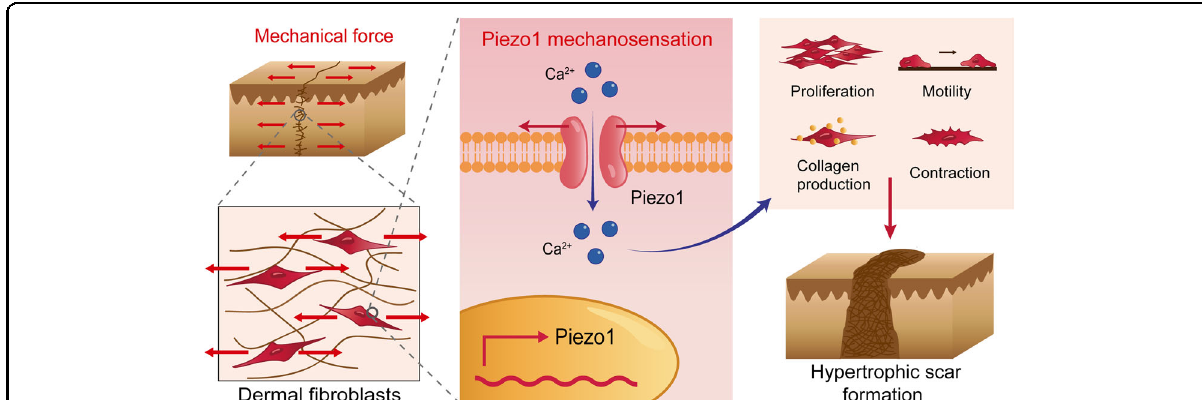
Fig. 6 The schematic diagram of mechanical stretch promotes HS formation through Piezo1. During hypertrophic scar formation, mechanical force delivered from the extracellular matrix to Piezo1, which localizes at cell membranes of dermal fi broblasts. Then, mechanical force triggers Piezo1 overexpression and Piezo1-mediated calcium concentration in dermal fi broblasts. In addition, Piezo1 activity promotes proliferation, migration, and differentiation of dermal fi broblasts in response to mechanical force, subsequently contributing to mechanical force-induced hypertrophic scar